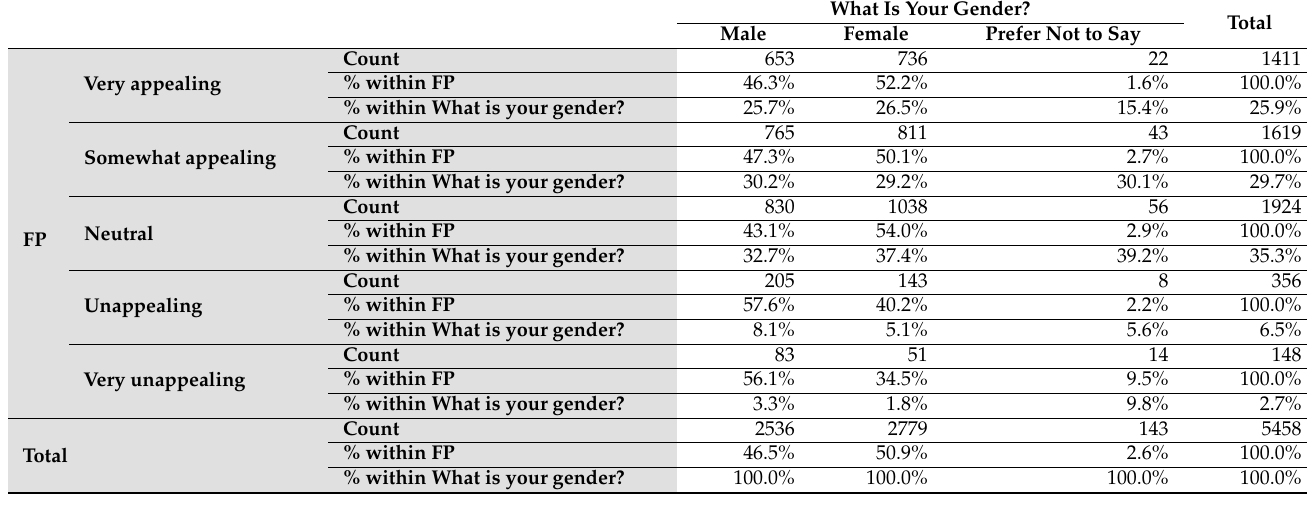
Table 6. Functional private value of EVs and respondents’ gender cross-tabulation.